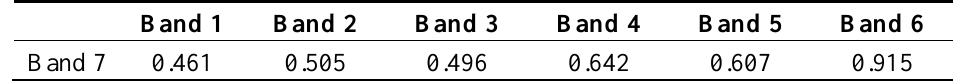
Table 1. Adjusted coefficient of determination (adjusted-R 2 ) at a given location between MODIS bands 1–6 and band 7.